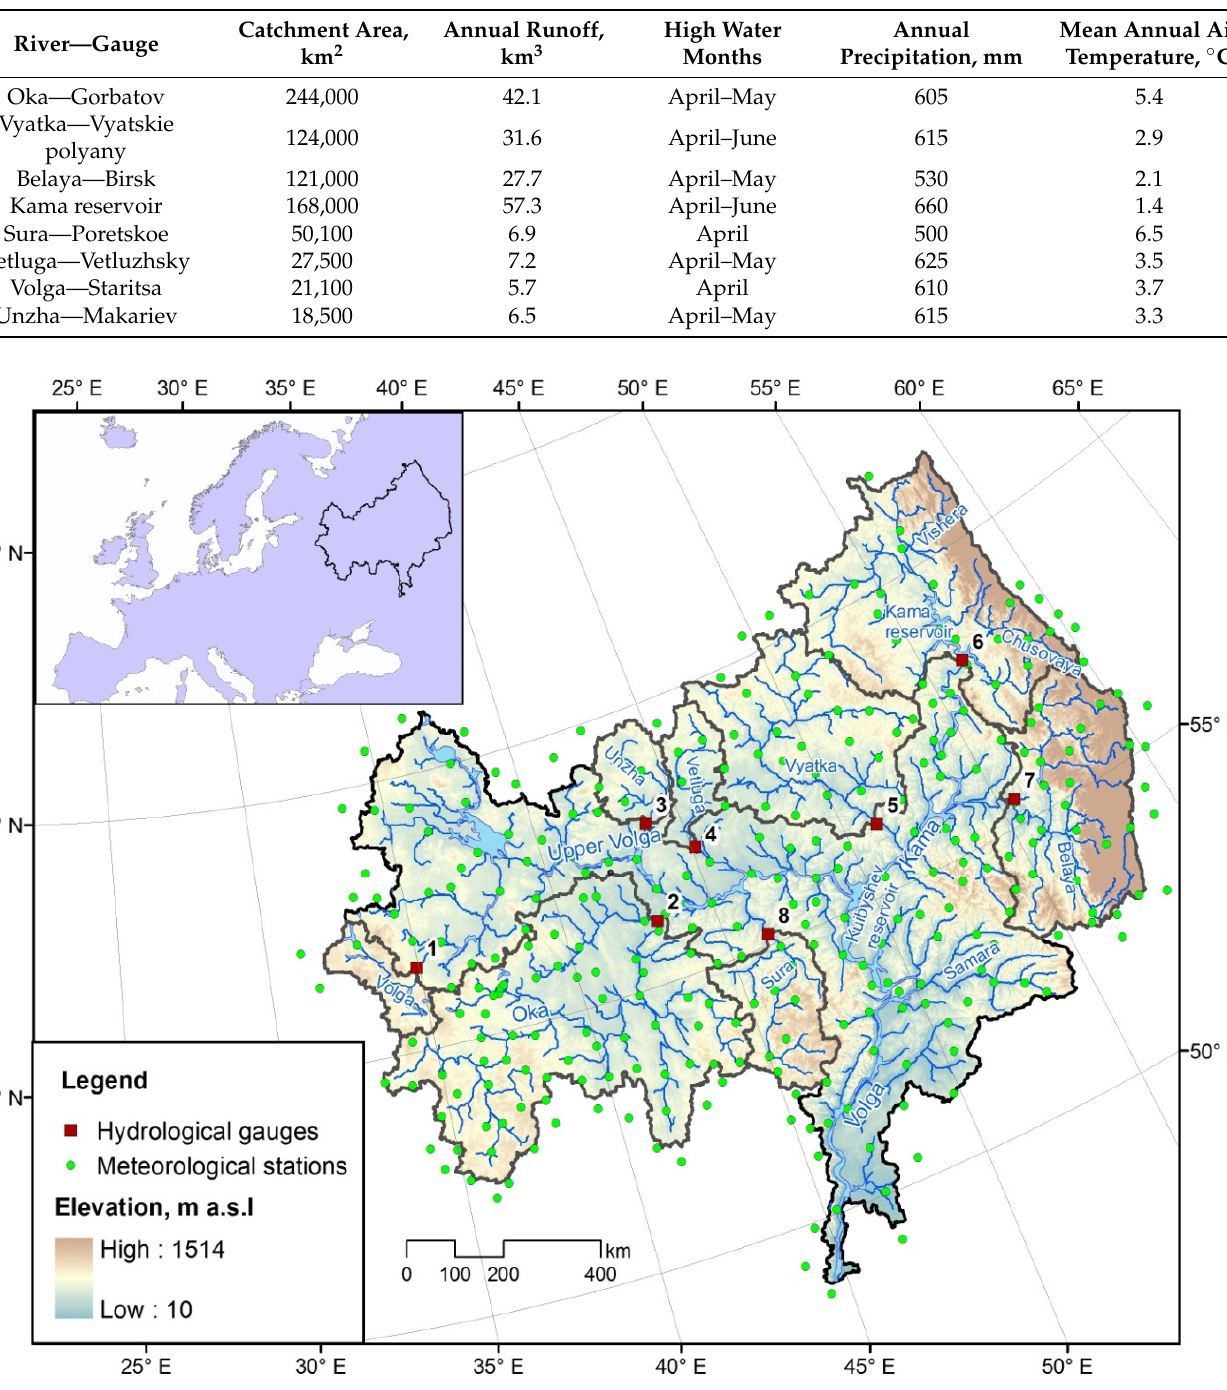
Table 1. Main hydrometeorological characteristics of the eight studied catchments of the Volga basin for the period 1986–2014.